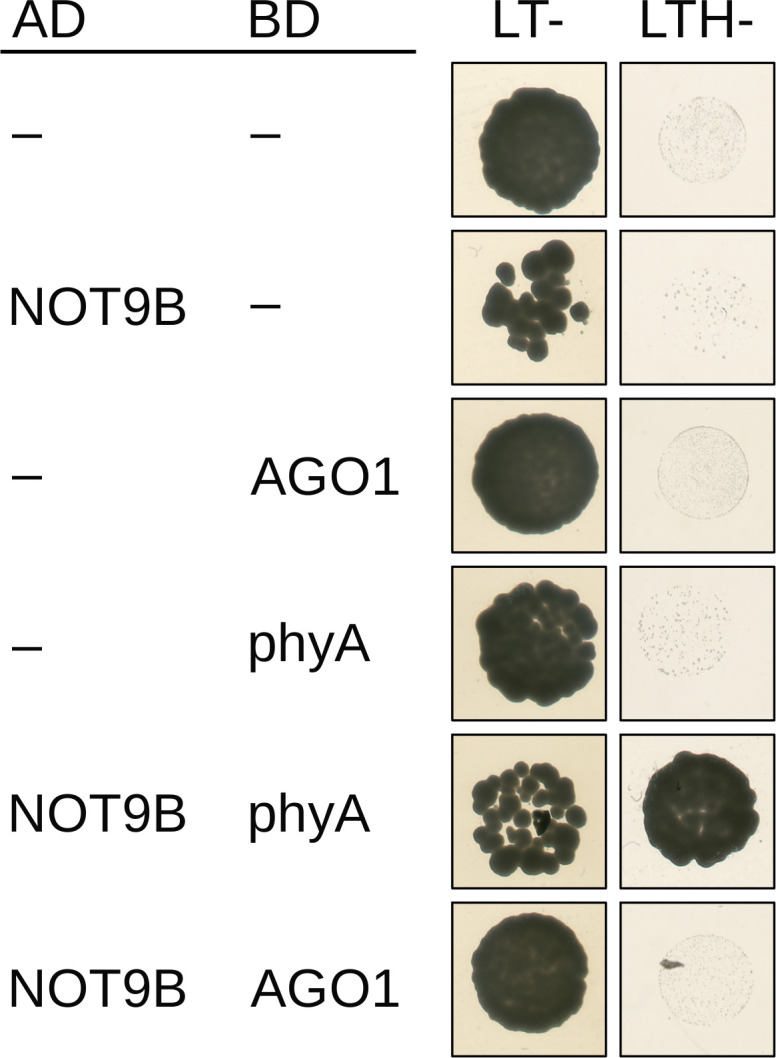
Yeast-two-hybrid growth assay for NOT9B and AGO1.AH109 cells were transformed with plasmids coding for indicated AD and BD fusion proteins and grown on CSM LTH- plates supplemented with 1 mM 3-AT to test for interaction. Growth on CSM LT- plates was used as transformation control.